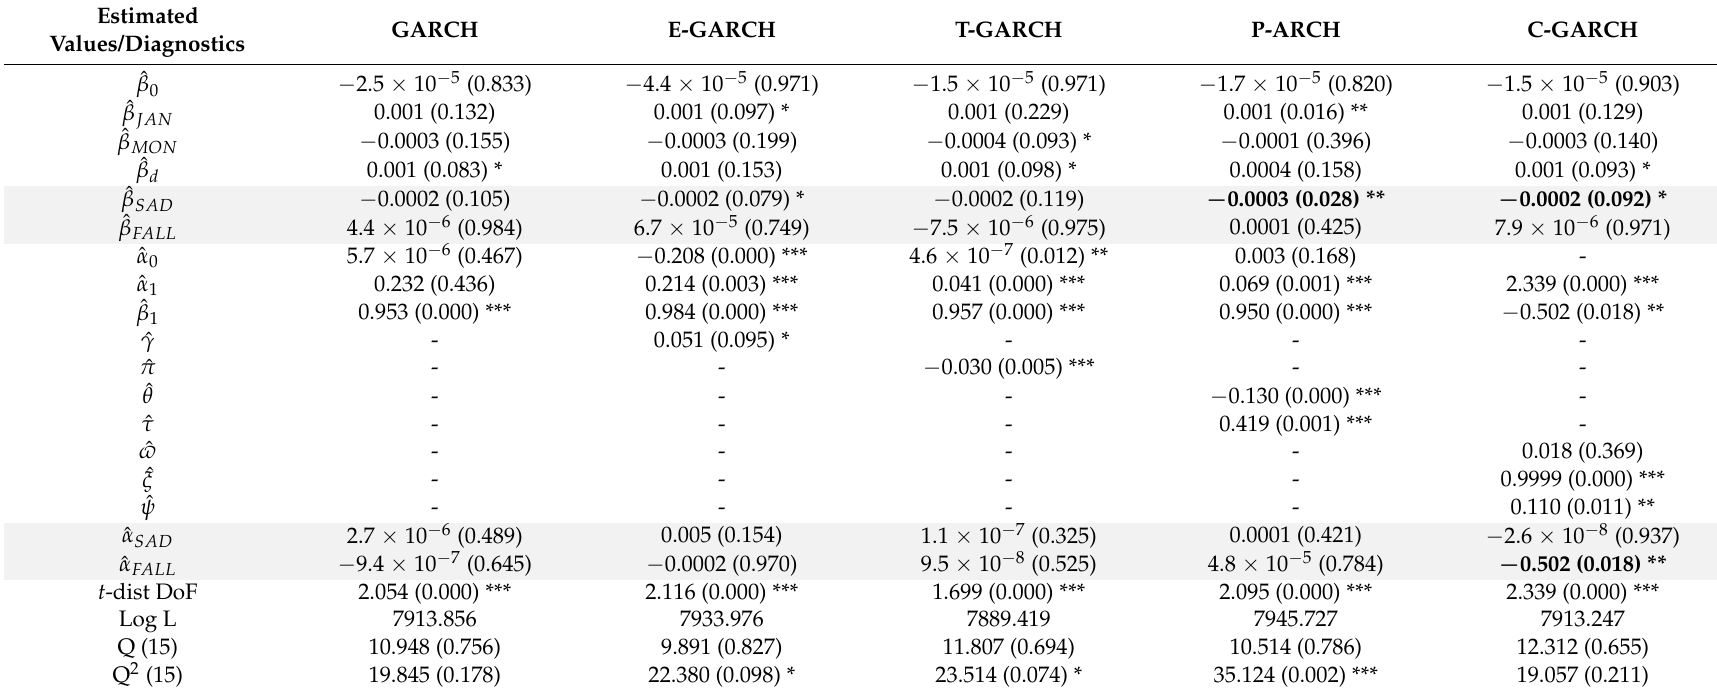
Table A3. Different GARCH specifications for